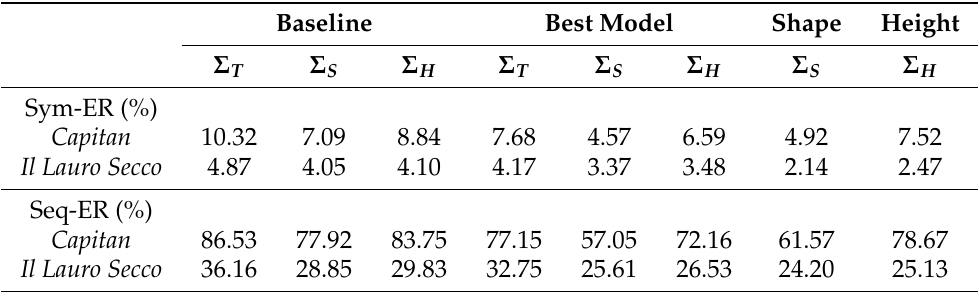
Table 4. Detailed comparison in terms of the Symbol (Sym-ER) and Sequence (Seq-ER) Error Rates of the InterRNN proposal (denoted as best model ) against the baseline case as well as the cases in which the base neural configuration is trained using the Σ S and Σ H vocabularies. Note that, for both the baseline and best model cases, we report the error rates when the predicted labels are decoupled in terms of their shape and height base